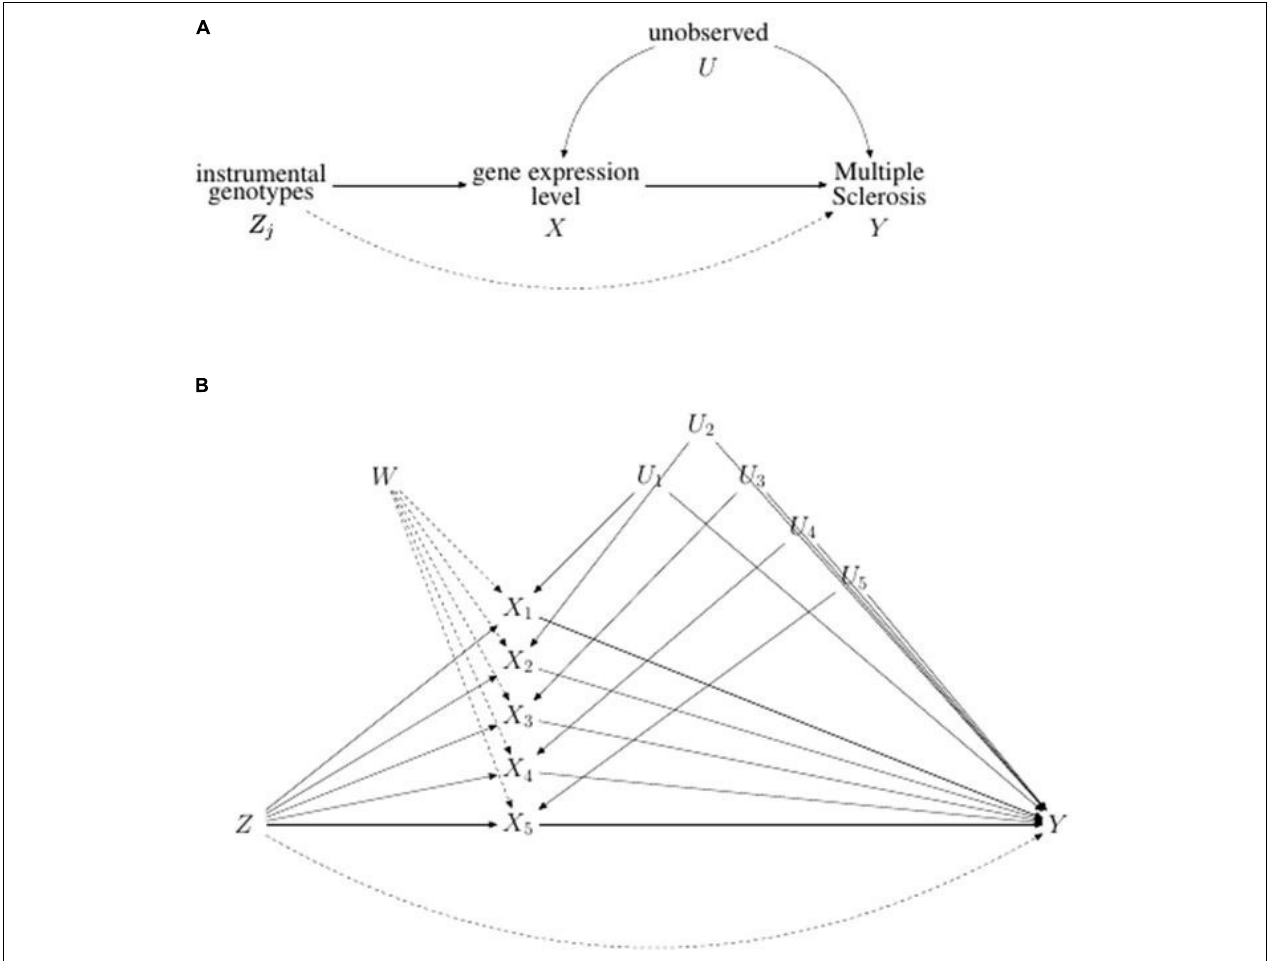
FIGURE 2 | Directed acyclic graph illustrating (A) the univariable and (B) the multivariable Mendelian Randomization problem. In (A) the potential violation of IV assumption represented by the direct pleiotropic effect of Zj on Y is indicated by a dotted line. In (B) causal graph illustrating multivariable Mendelian randomization assumptions for a set of genetic variants Z , five risk factors X 1 , X 2 , X 3 , X 4 and X 5 , and the binary outcome Y. The direct pleiotropic effect of Z on Y is represented by a dotted line. The node W represents the possibility that each risk factor, X , could influence each